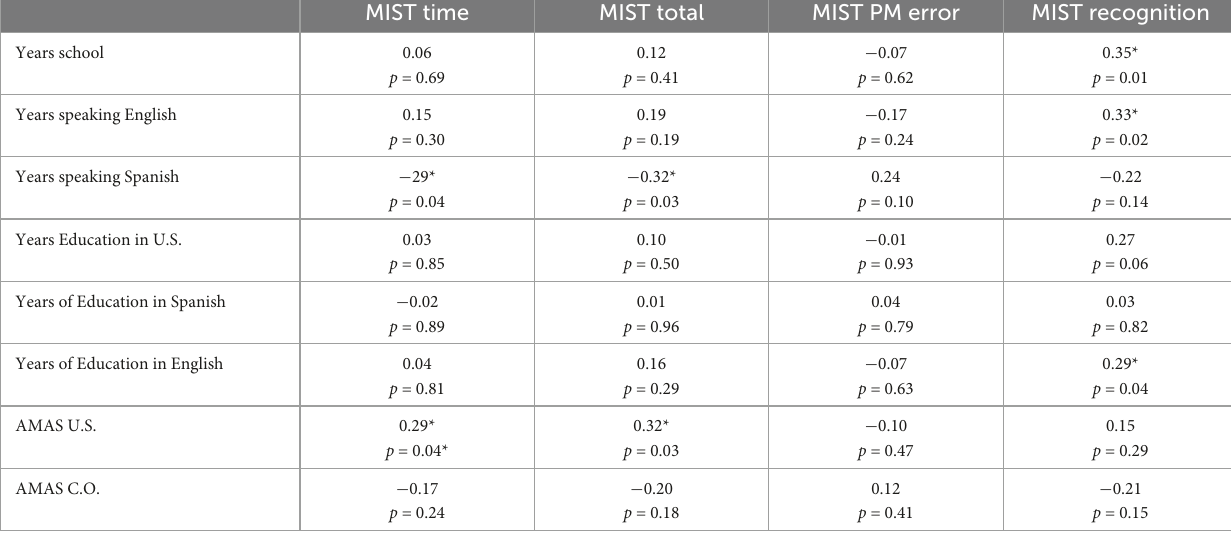
TABLE 3 Acculturation and language variables and Memory for Intentions (MIST) variables correlations r and p -values n = 50.